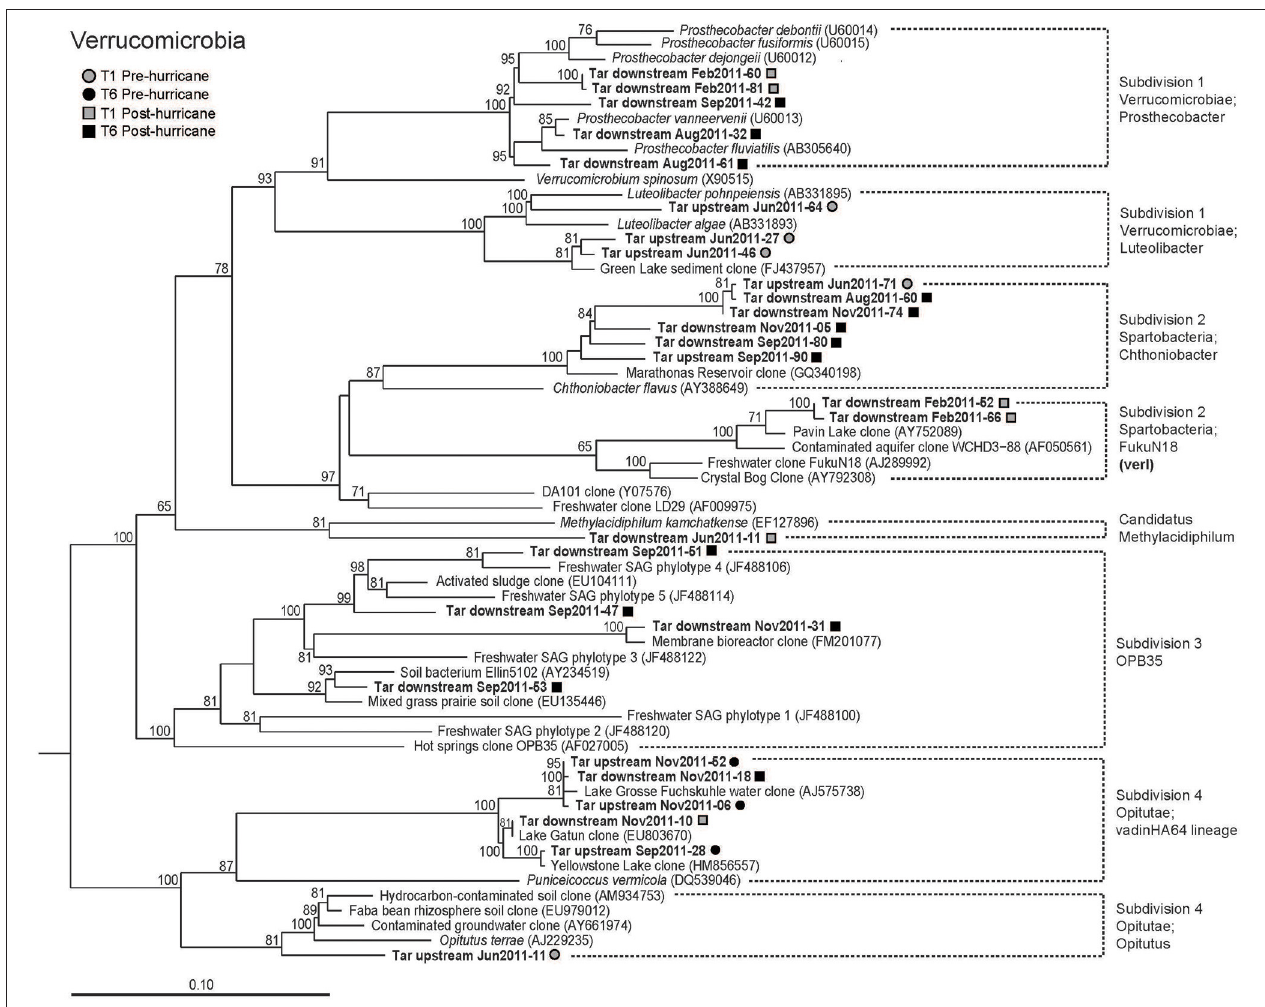
FIGURE 6 | Phylogeny of subdivisions of the phylum Verrucomicrobia . Individual well-defined clusters are identified in the tree. Wherever possible, each identification includes a class and genus name; otherwise, a descriptive name is given to each cluster. “verI” refers to a freshwater lineage within Subdivision 2 as classified by Newton et al. (2011). Clones in bold type font are the Tar River clones; cultured species are italicized. The rapid bootstrap analysis feature of the Maximum Likelihood algorithm was used. The tree is rooted by Lentisphaera araneosa (AY3490428) and Victivallis vadensis (AY049713).